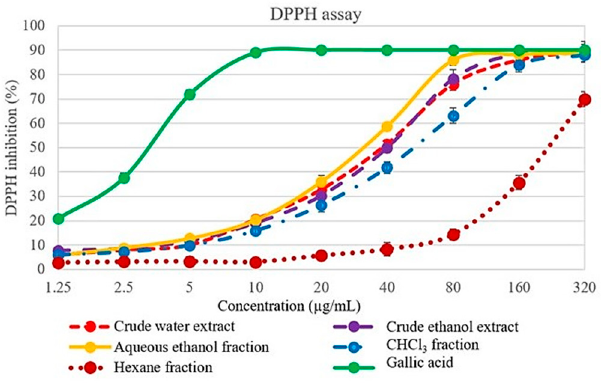
Figure 5. Effect of L. martabanica fractions on 2,2 ′ -diphenyl-1-picrylhydrazyl (DPPH) free radicals scavenging. Values are expressed as mean ±S.E.M. from three independent experiments.